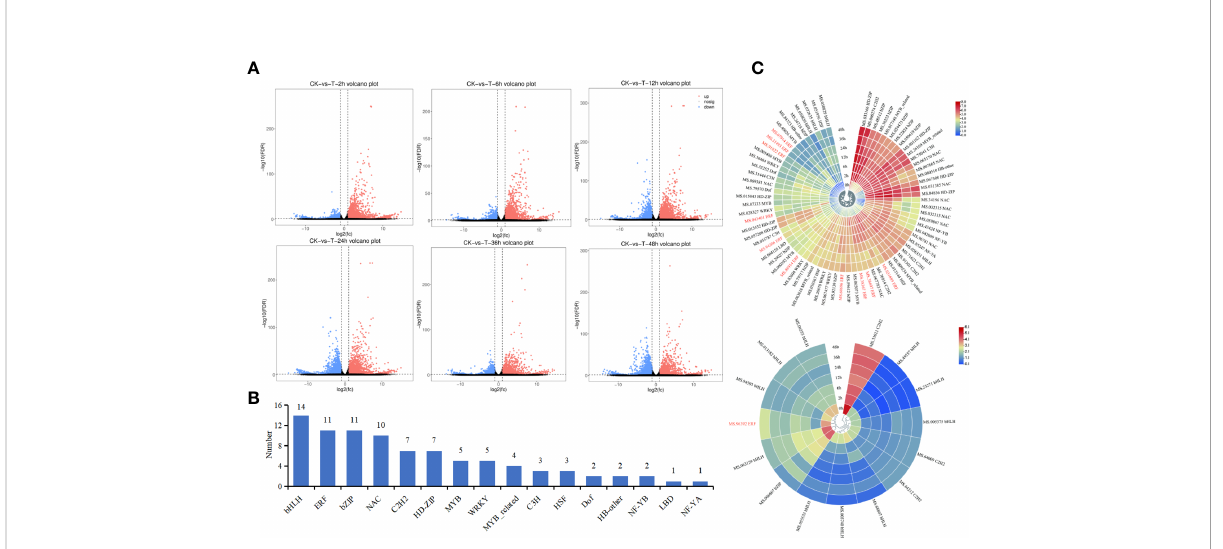
FIGURE 2 Analysis of differentially expressed genes at each time point under mannitol treatment. (A) , Volcano of difference among treatments. The horizontal coordinate indicates the log 2 (FC) of the difference between two groups, and the vertical coordinate indicates the negative log 10 value of the FDR of the difference between the two groups. Red (up-regulated expression of group_2 relative to group_1) and blue (down-regulated expression) points indicate difference in gene expression (judged by FDR < 0.05, and more than two-fold difference), and black points indicate